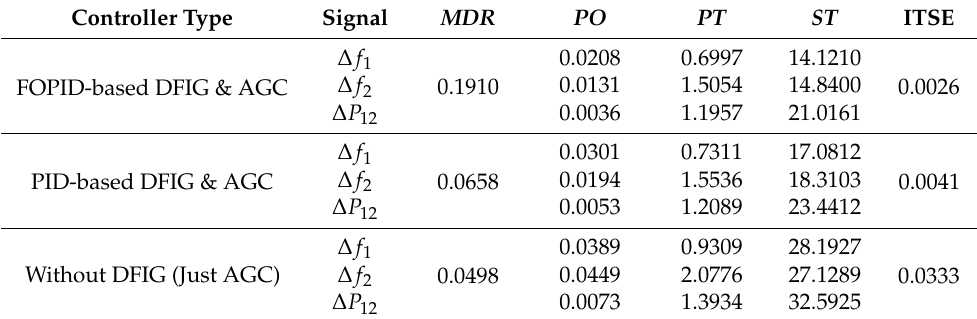
Table 3. Frequency deviation and tie-line power characteristics of FOPID, PID and just